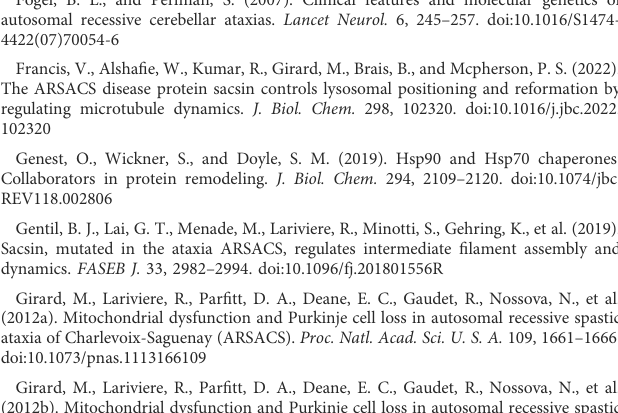
SUPPLEMENTARY FIGURE S1 Molecular Dynamic simulation of sacsin-ATP complex. (A) Cluster analysis of the loop; the most populated cluster is shown in red, the second in orange, the third in yellow, the fourth in green and the least populated in blue. (B) RMSD analysis of protein C-alpha (blue) and ligand (magenta). (C) Protein-ligand interaction diagram. Interactions are categorized into four types: Hydrogen Bonds (green), Hydrophobic (lilac), Ionic (pink) and Water Bridges (blue). The stacked bar charts are normalized over the course of the entire trajectory. Values over 1.0 are possible as some protein residue may make multiple contacts of same subtype with the ligand. SUPPLEMENTARY FIGURE S2 Hsp90 middle and C-terminal regions and corresponding segments of sacsin that do not superimpose. PyMol cartoon of Hsp90 (yellow and blue, residues 386 to 677) and sacsin (green and red, residues 487 to 772). The blue long helix of the Hsp90 middle domain and that of sacsin are superimposed. The rest of the structure shows no immediately recognisable common topology. SUPPLEMENTARY FIGURE S3 Molecular Dynamic simulation of sacsin-geldanamycin complex. (A) Cluster analysisof theloop;themostpopulatedcluster isshowninred, the second in orange, the third in yellow, the fourth in green and the least populated in blue. (B) RMSD analysis of protein C-alpha (blue) and ligand (magenta). (C) Protein-ligand interaction diagram. Interactions are categorizedinto four types:Hydrogen Bonds (green), Hydrophobic (lilac), Ionic (pink) and Water Bridges (blue). The stacked bar charts are normalized over the course of the entire trajectory. Values over 1.0 are possible as some protein residue may make multiple contacts of same subtype with the ligand. SUPPLEMENTARY FIGURE S4 MolecularDynamicsimulationofsacsin-AUY922complex. (A) Clusteranalysisofthe loop; themost populated cluster isshowninred,thesecond in orange, thethirdin yellow, the fourth in green and the least in blue. (B) RMSD analysis of protein C-alpha (blue) and ligand (magenta). (C) Protein-ligand interaction diagram. Interactionsarecategorizedintofourtypes:HydrogenBonds(green),Hydrophobic (lilac), Ionic (pink) and Water Bridges (blue). The stacked bar charts are normalized overthecourseoftheentiretrajectory.Valuesover1.0arepossibleassomeprotein residue may make multiple contacts of same subtype with the